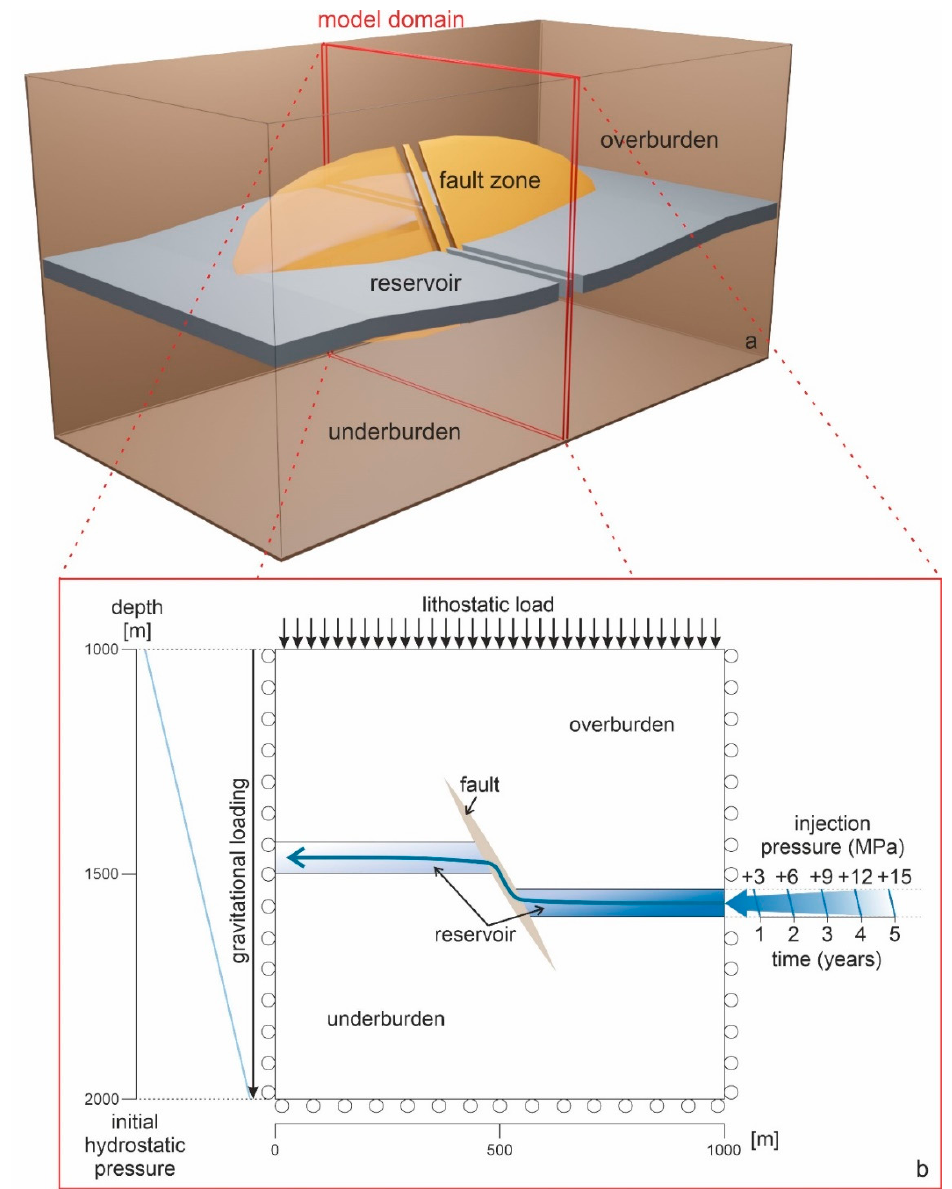
Figure 3. ( a ) The 3D model represents a slice of one-element width through the central section of a fault zone displacing a reservoir horizon (not to scale). ( b ) General model set-up (in side view) as well as initial and boundary conditions for the hydro-mechanical simulation. Model dimensions are 1 × 1 × 0.001 km centered around a 500 m long fault displacing a reservoir horizon. The model is located between 1 and 2 km depth. No displacements orthogonal to the model boundary are allowed at the base and vertical sides of the model (‘roller boundary condition’), whereas a pressure equivalent to the weight of the overburden acts on the model top. Initially, a hydrostatic pore pressure field is assumed. Subsequently, the pore pressure at the nodes on the right side of the downthrown reservoir section is increased at a rate of 0.75 MPa every 3 months until after 5 years a final increase of 15 MPa is reached.